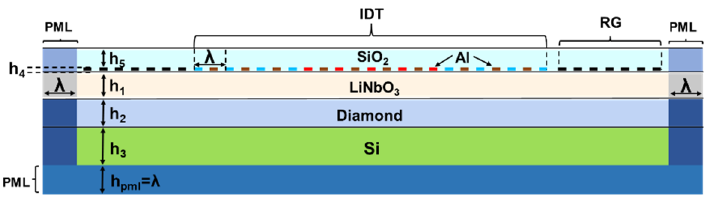
Figure 1. Schematic representation of the SiO 2 /IDT/LiNbO 3 /diamond/Si multilayer structure.